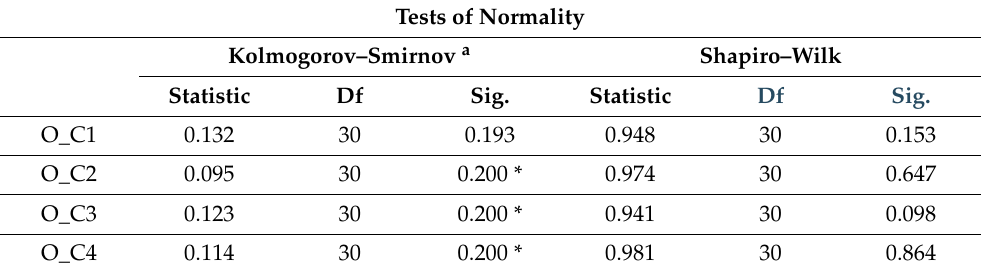
Table 6. Normality test on occupancy value of red box capacity.